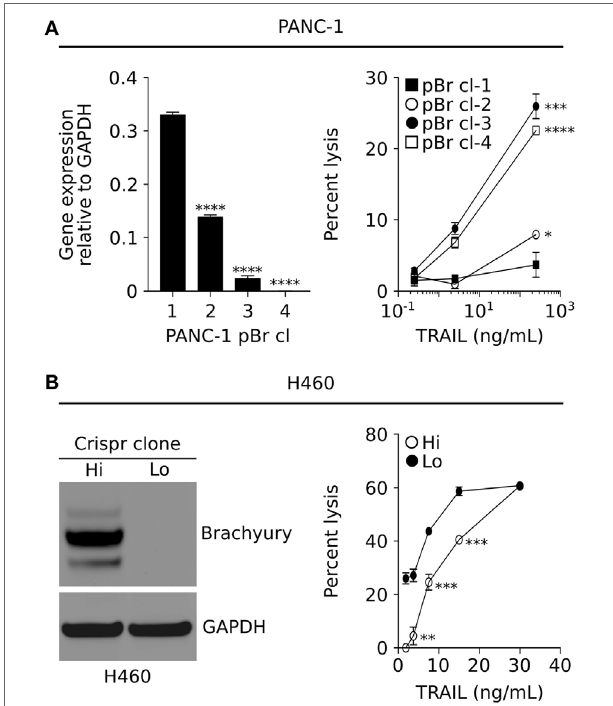
FigUre 1 | Brachyury associates with increased resistance to immune- mediated killing. (a) Relative brachyury expression in four clonally derived human PANC-1 cell lines (left panel), and their associated sensitivity to lysis by TNF-related apoptosis-inducing ligand (TRAIL) (right panel). (B) Western blot analysis of brachyury expression in two clonally derived populations of H460 generated via the CRISPR approach (left panel), and their sensitivity to lysis by TRAIL (right panel). Presented data are representative of three independent